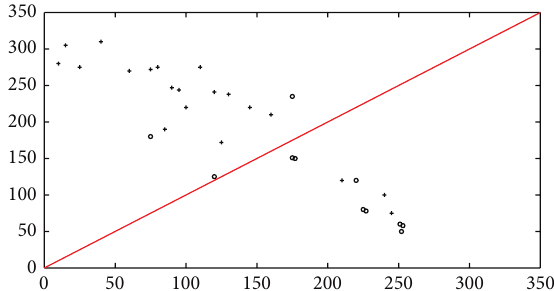
Figure 13: Scatter plot of real-time sample set (30) on BPN classifier for benign and malignant tumor in real-time image dataset. Here “ ∘ ” denotes tumor malignant prognosis and “+” denotes patients with benign tumor